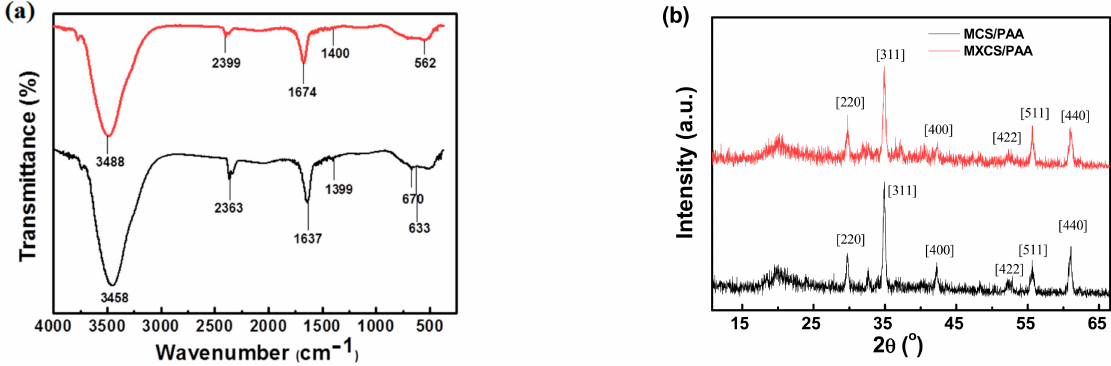
Figure 2. ( a ) FT-IR spectrum, ( b ) XRD spectrum of MCS/PAA and